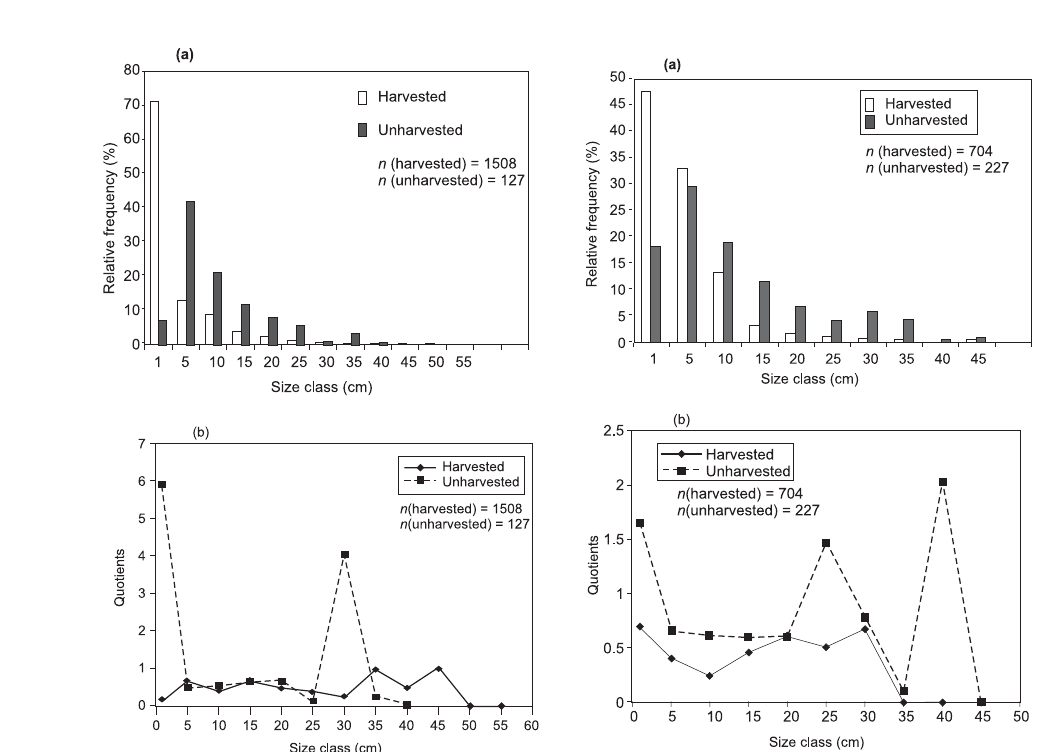
Fig. 3. Population structure of harvested and unhar- vested Rapanea melanophloeos populations (a) rela- tive frequencies and (b) quotients between numbers of trees in successive size